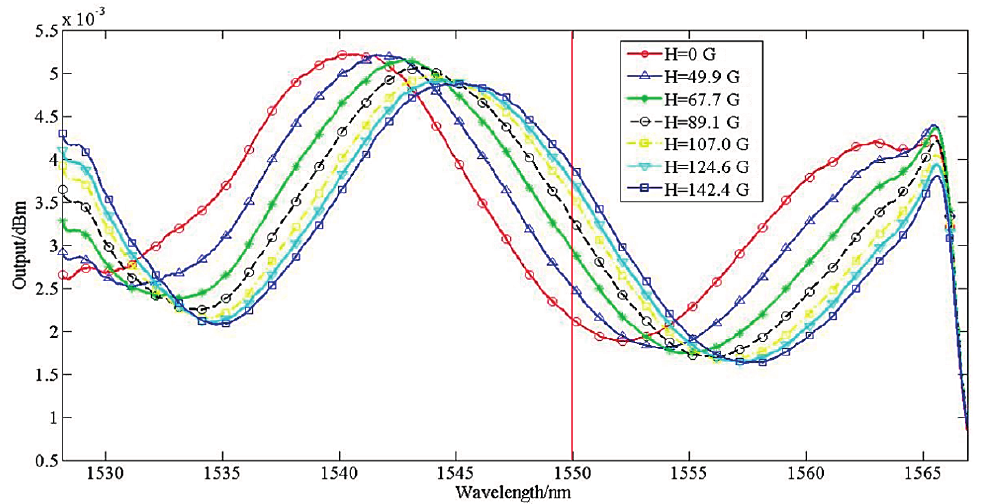
Figure 5. Signals of interference under different current